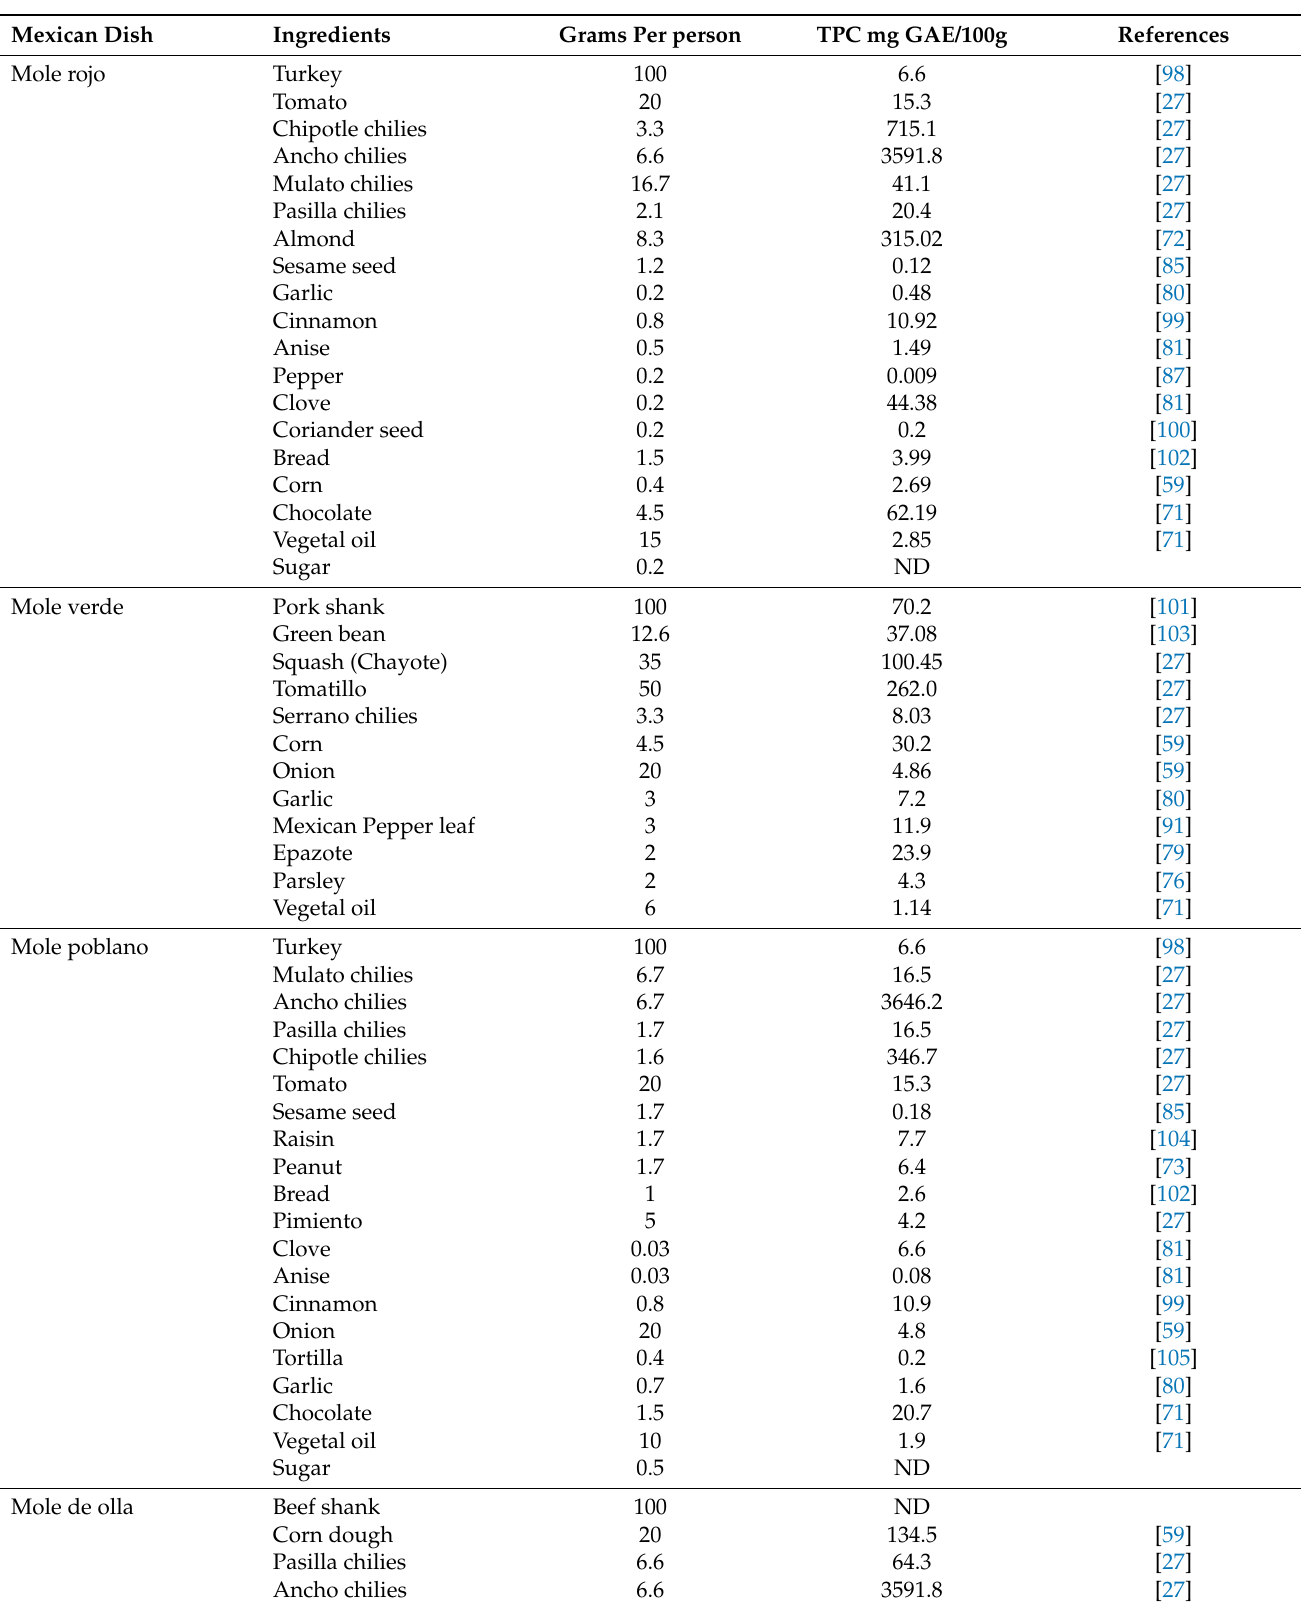
Table A2. Phenolic compounds in Mexican